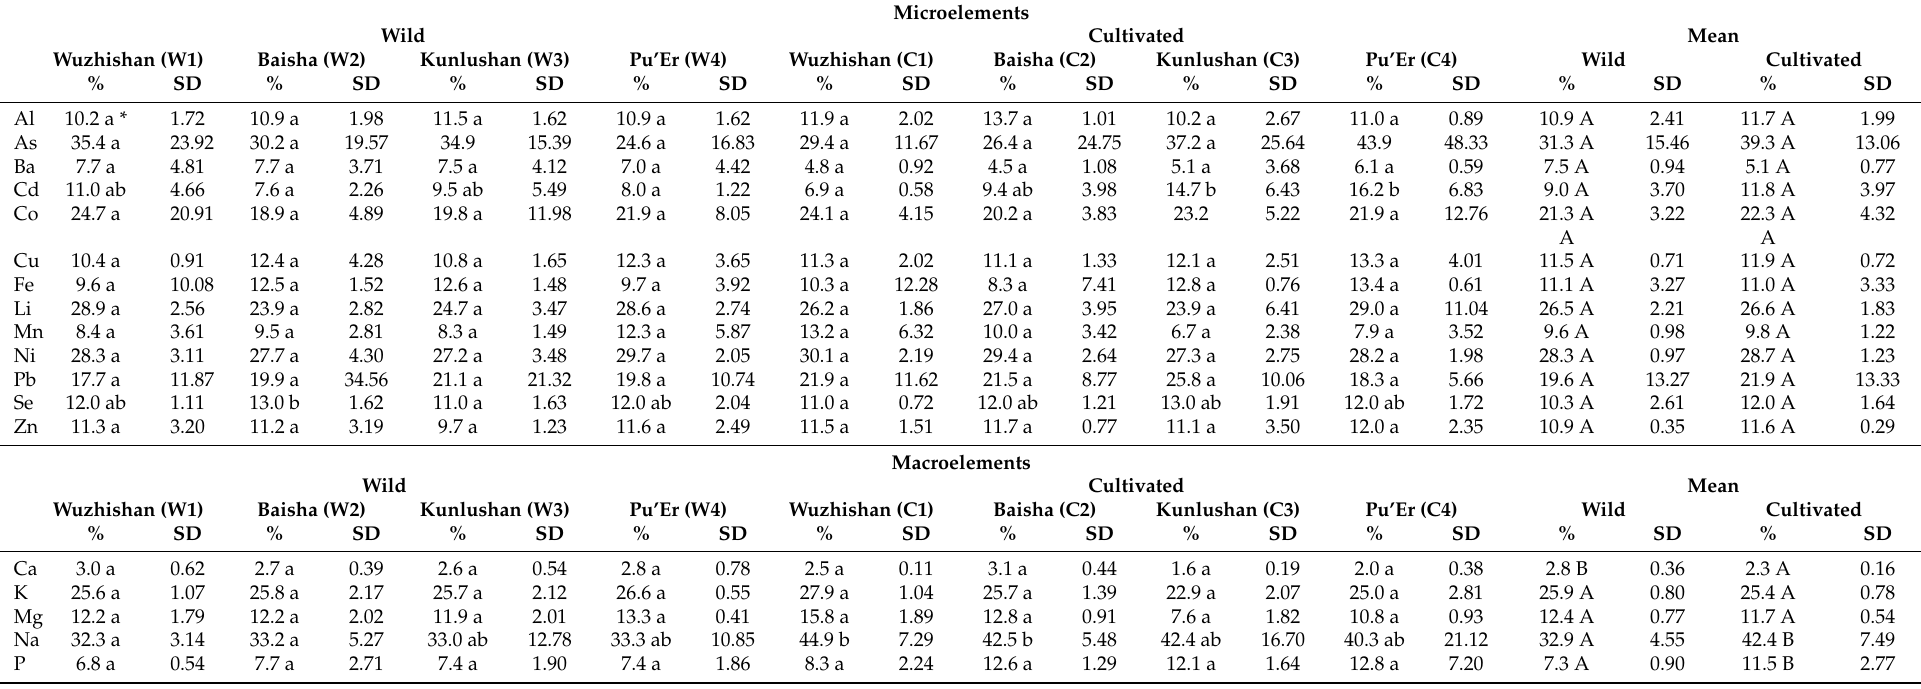
Table 4. Transfer coefficients for macro- and